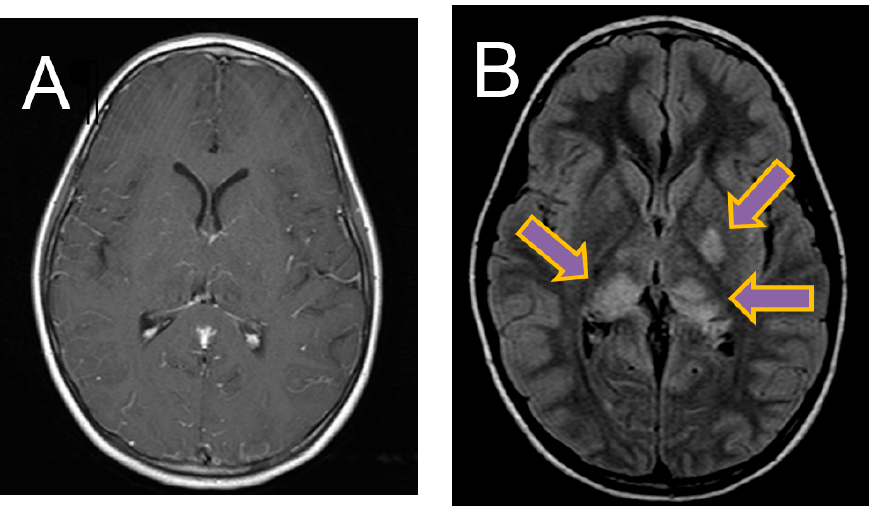
Figure 1. Magnetic resonance imaging (MRI) brain images. ( A ) Axial T1-weighted image showing diffuse leptomeningeal enhancement. ( B ) Axial FLAIR image showing FLAIR hyperintensity in left basal ganglia and bilateral thalami.